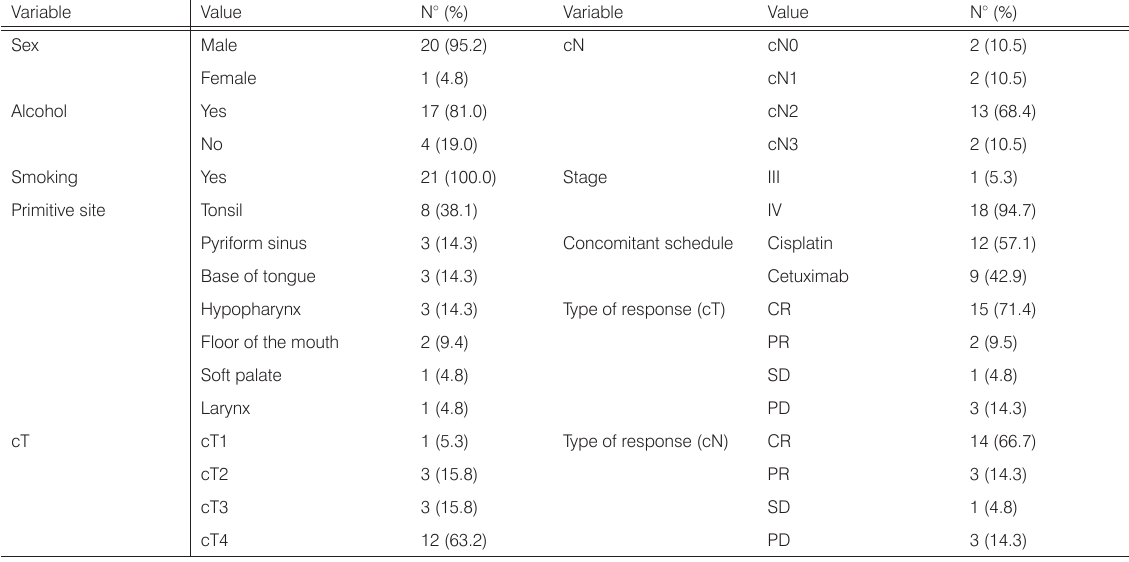
Table 1. General case